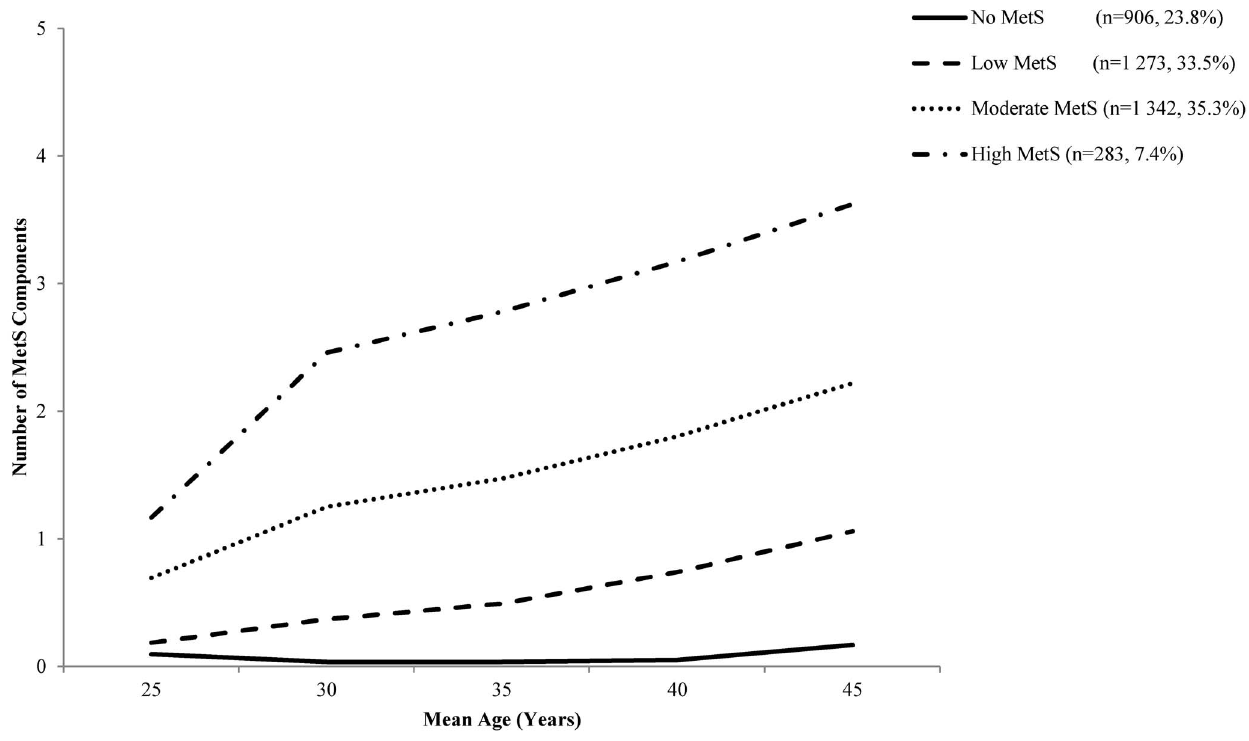
Figure 2. Group-based trajectory of MetS development based on the number of components attained over a 20-year span. Trajectories were determined by PROC TRAJ censored normal modelling in 3 804 apparently healthy young adults. Four trajectories were observed and denoted as No MetS (No MetS: n=906), Low MetS (n=1 273), Moderate MetS (n=1 342), and High MetS (High MetS: n=283).